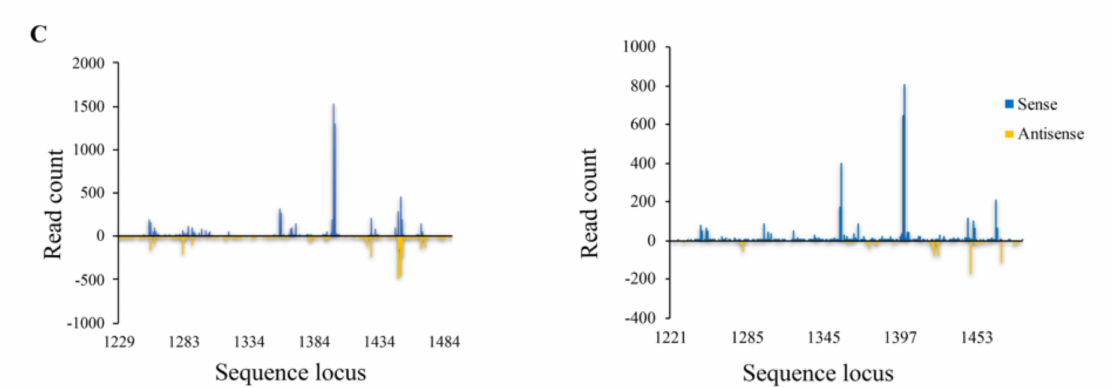
Figure 6. Distribution and frequency of small RNAs aligned to alk target gene in transgenic maize immature kernel and leaves tissues. ( A ) High levels of 21, 22 and 24 bp alk -specific small RNA were detected in transgenic leaves (left) and kernels (right) of the Alk-4 maize. ( B ) Both anti-sense and sense small RNA were detected in the transgenic tissues. A higher percentage of the alk -specific sense strand than that of the anti-sense strand was detected. ( C ) The region where the highest alk -specific read counts were found is between the 290 bp, which coincides with the size of the alk gene. The horizontal axis represents the relative position along the alk gene, and the vertical axis represents the number of alk -small RNAs reads mapped to alk